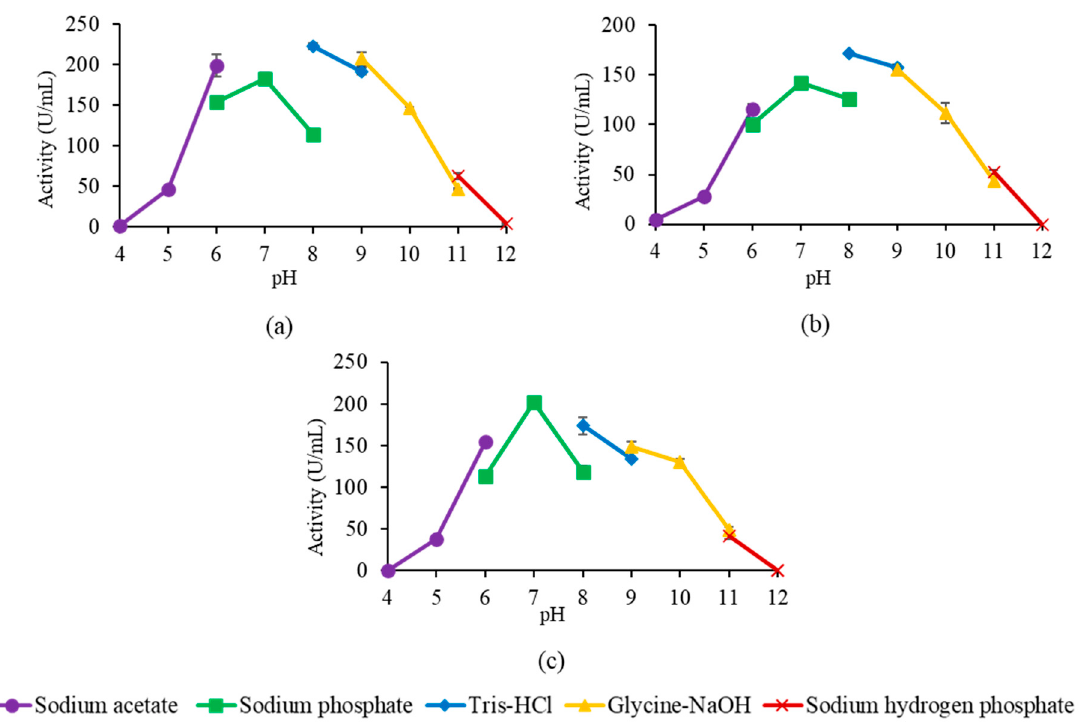
Figure 8. E ff ect of pH on the activity of mutant lipases. ( a – c ) pH profile of A8V, A8P and Figure 8. Effect of pH on the activity of mutant lipases. ( a )–( c ) pH profile of A8V, A8P and A8E, A8E, respectively.